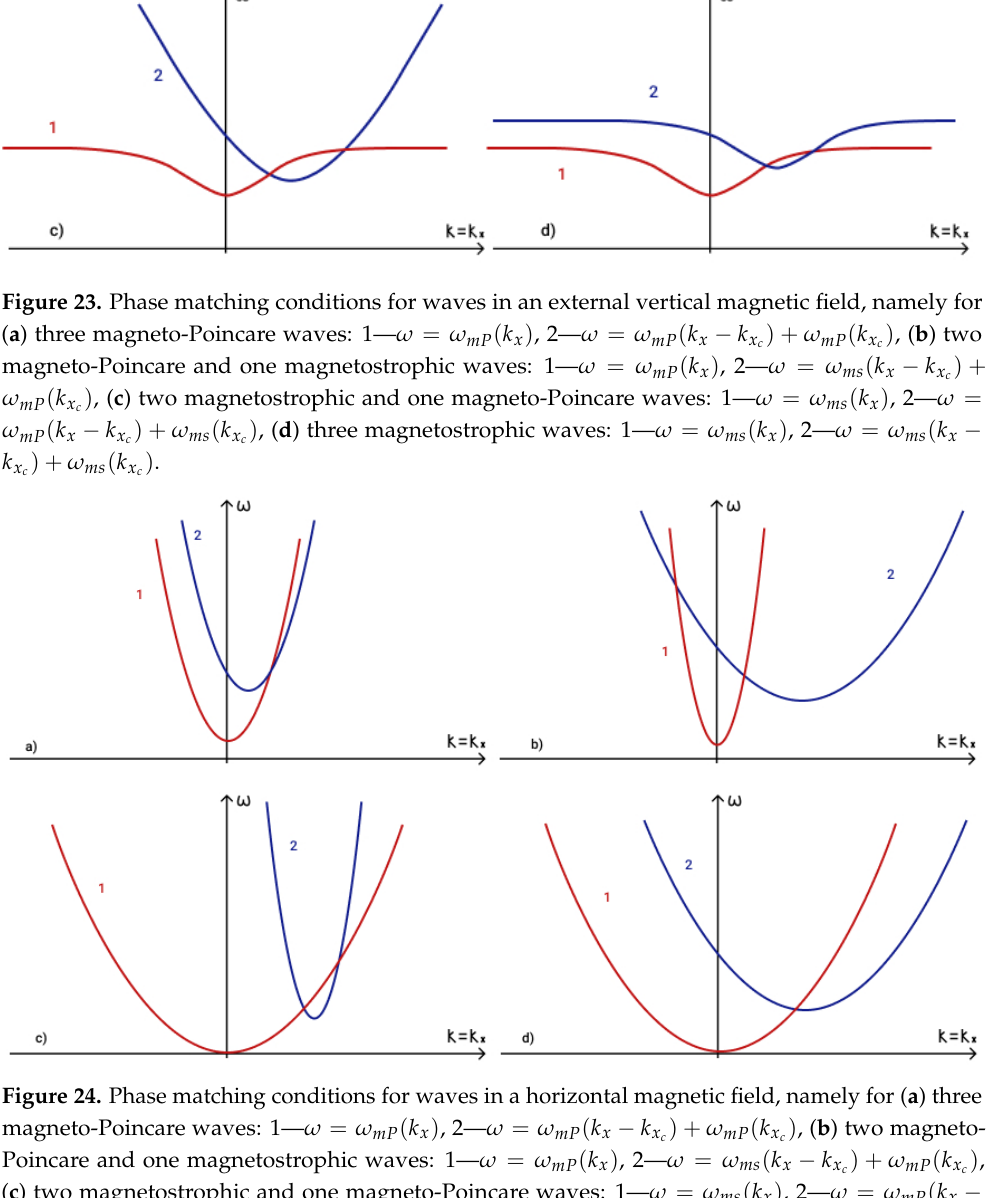
) + ω ( k x ) , ( b ) two magneto- mP c c ) + ω ( k x ) , mP c c ) + c